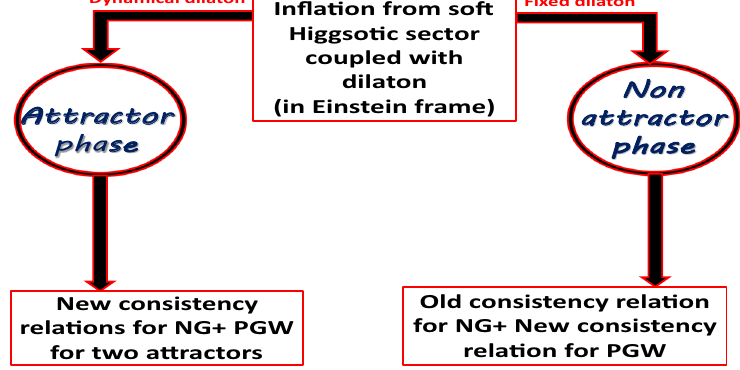
Diagrammatic representation of non-attractor phase of soft Higgsotic inflation. In this representative diagram we have shown the steps followed during the computation.